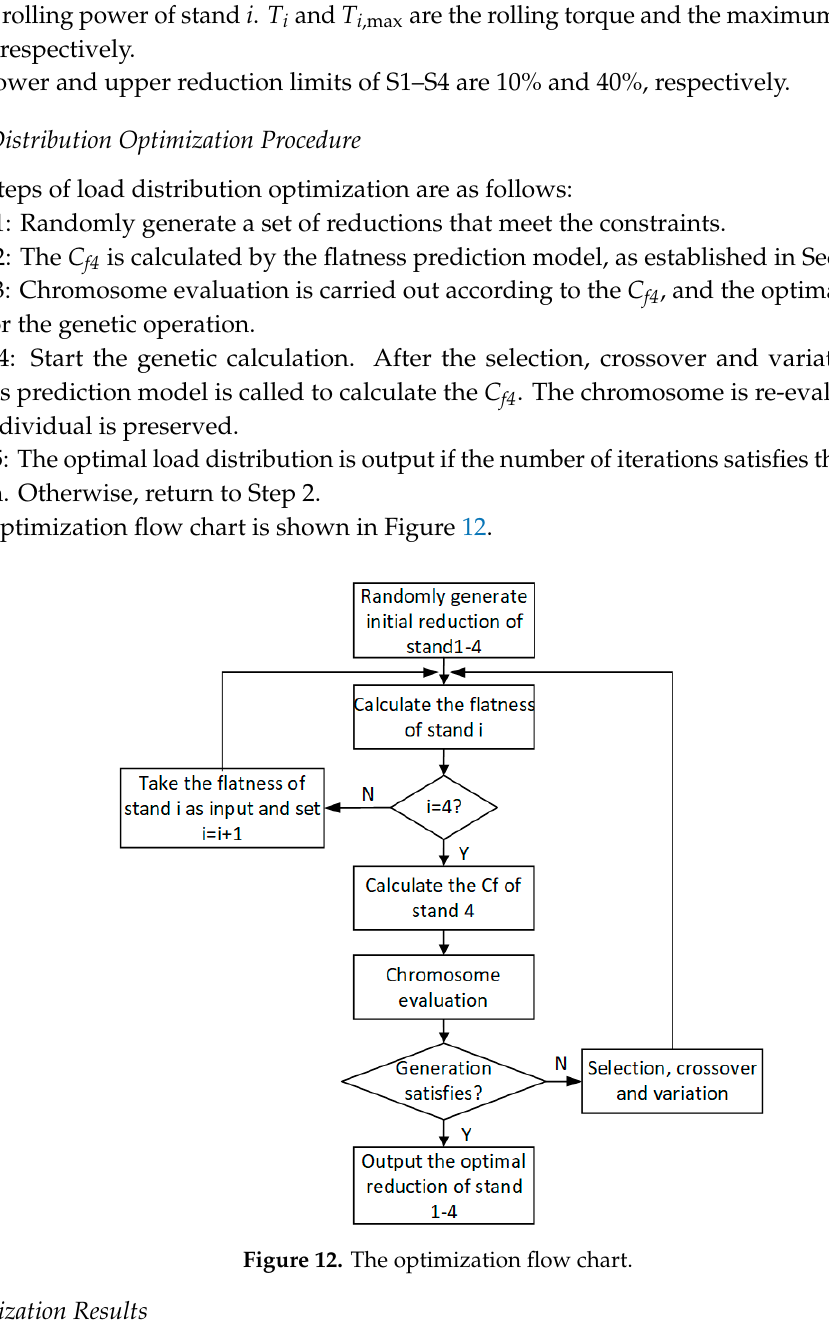
( b ) Figure 13. The ( a ) best fitness evolution for genetic algorithm and ( b ) reduction evolution. As indicated in Figure 13a, the solution process is converged after 30 generations. As shown in Figure 13b, the reduction of S1 and S3 increased slightly. The reduction of S2 increased from 23.8% to 31%, while the reduction of S4 decreased from 24.3% to 18.5%. The optimization results are consistent with the simulation results in the trend of Section 3. The optimal reduction of 28.6%, 34.6%, 27.3%, and 18.6% is proposed for S1, S2, S3, and S4, respectively.